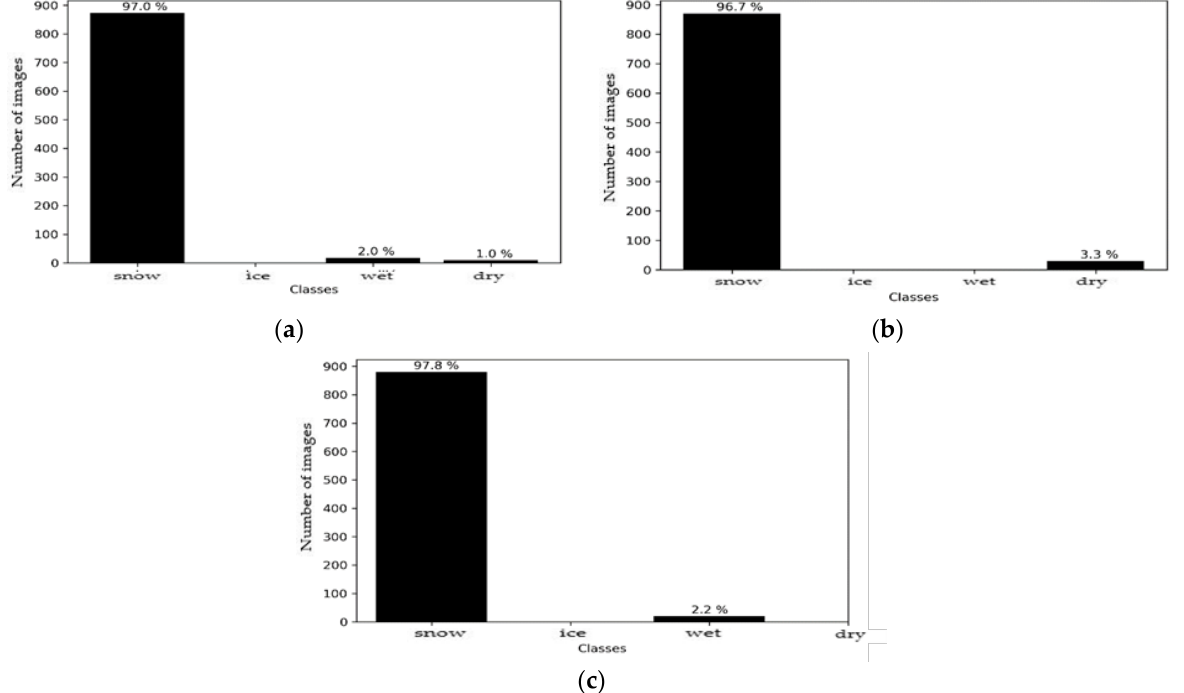
Table 3. Video processing speed.